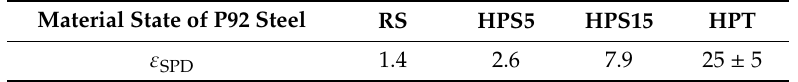
Table 1. Predeformation ( ε SPD ) imposed by methods of severe plastic deformation (SPD).